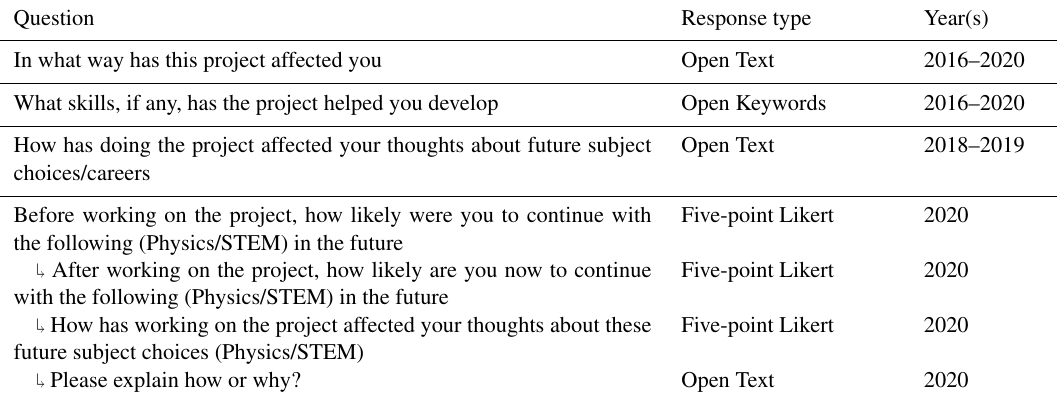
Table A1. Questions posed to students.